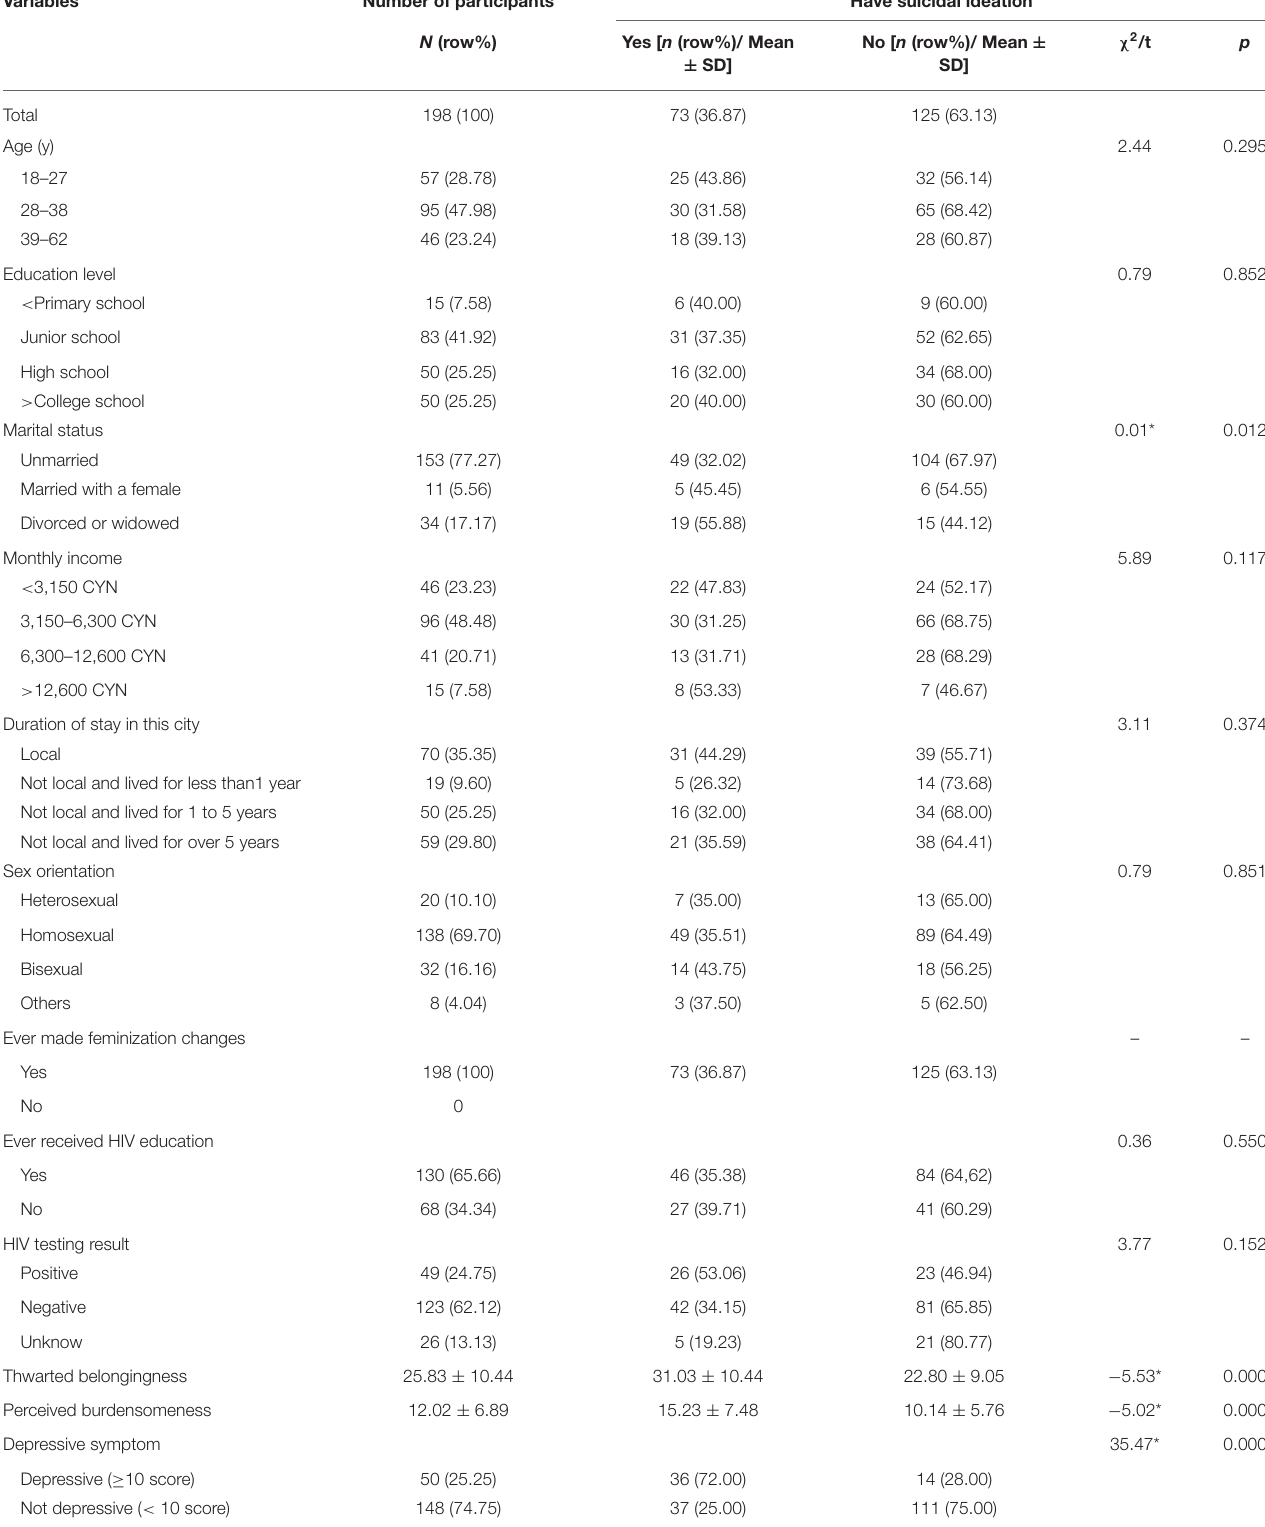
TABLE 1 | Background characteristics of transgender women ( N =